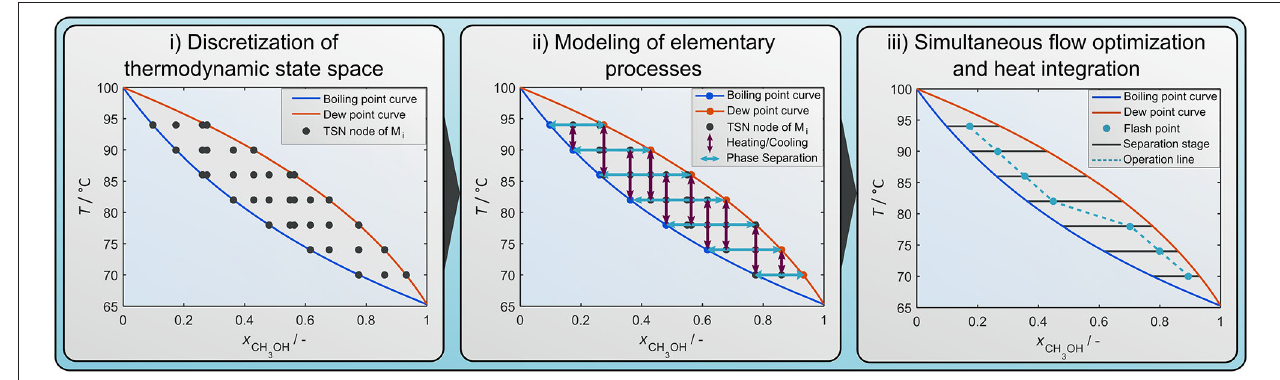
FIGURE 2 | Schematic procedure of the FluxMax approach for distillation column design. Adapted from Schack et al. (2019).